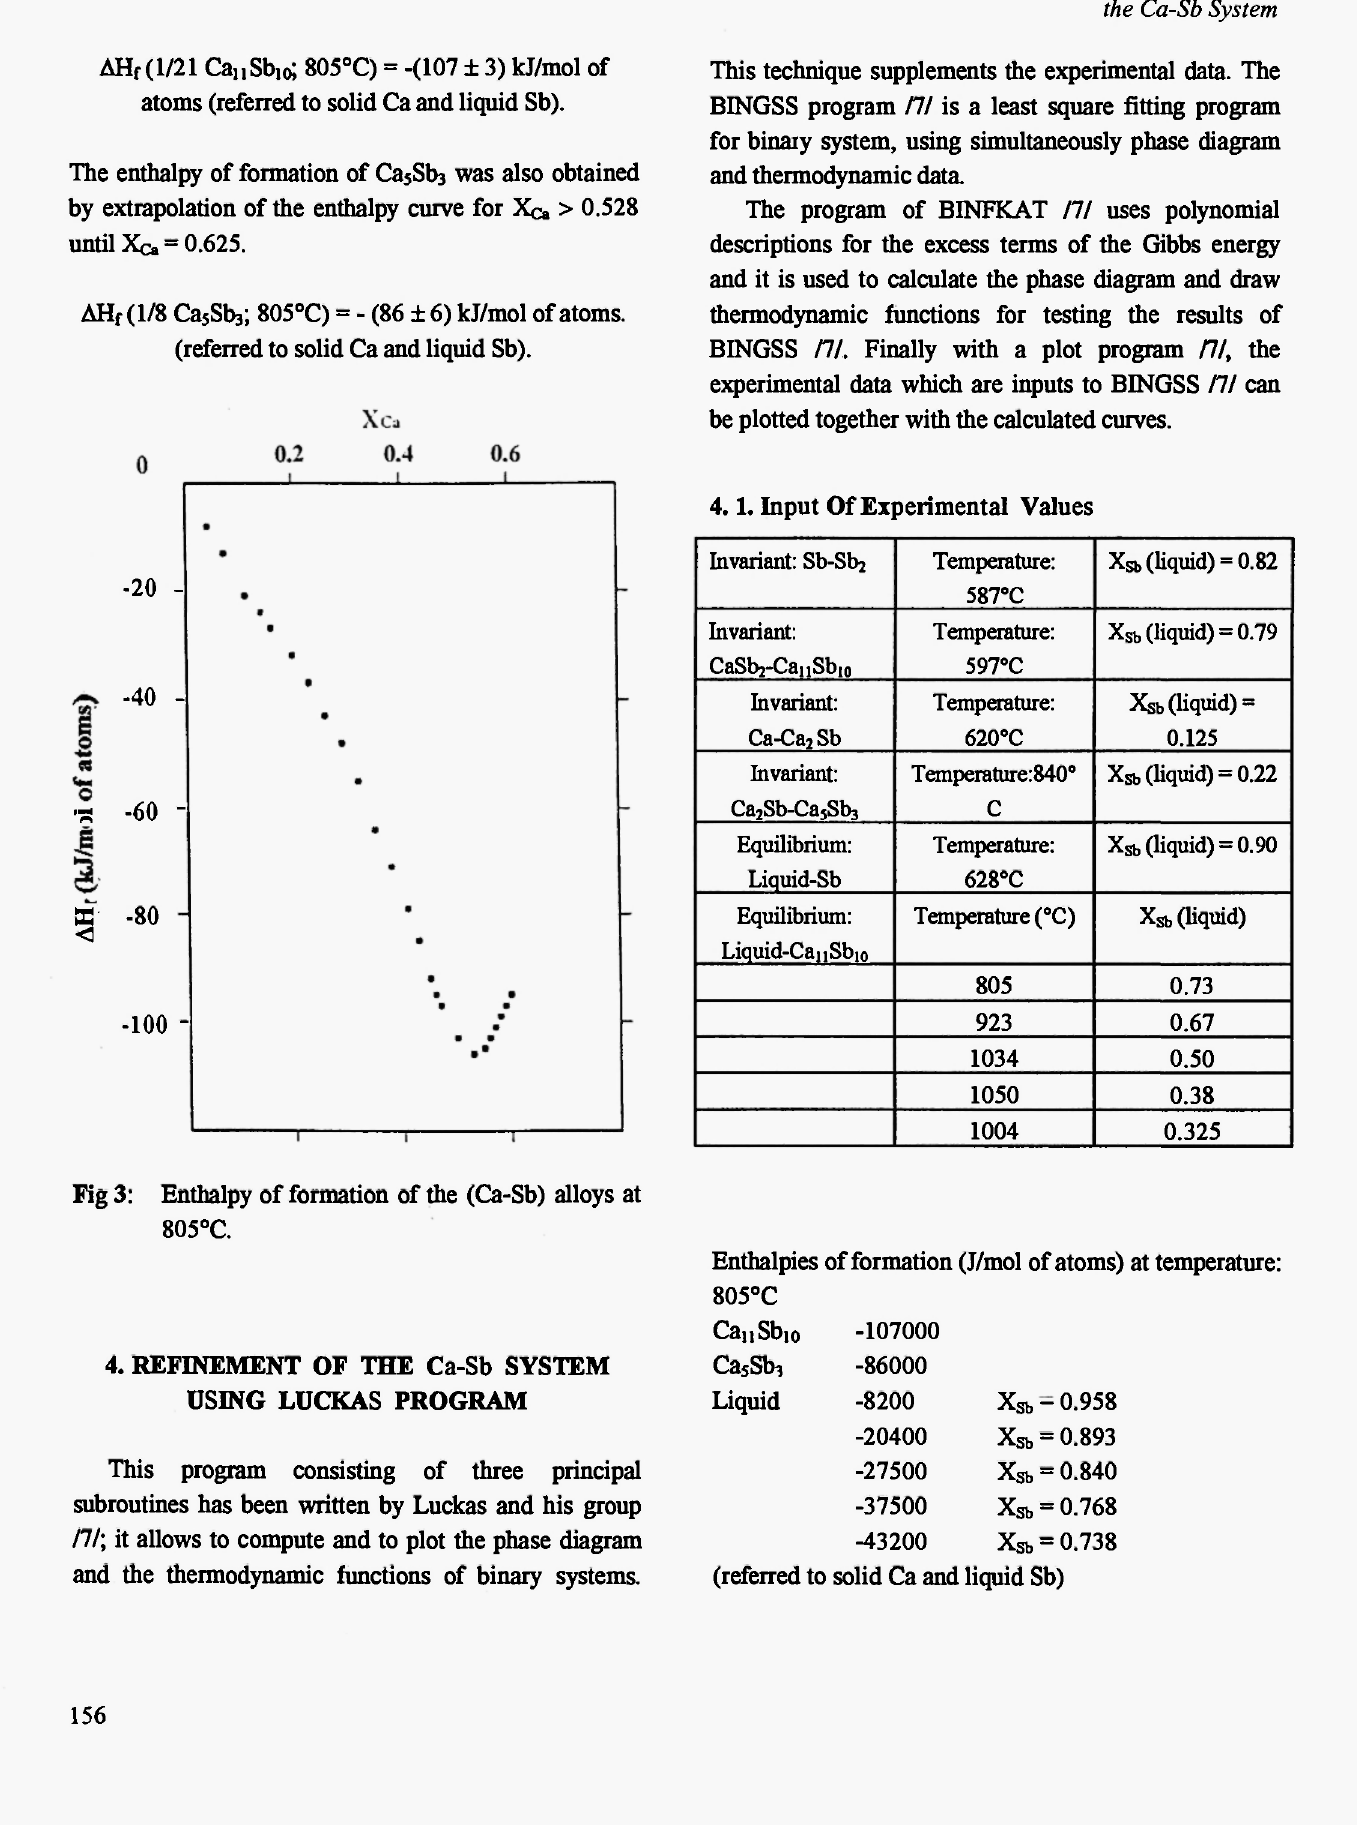
Fig 3: Enthalpy of formation of the (Ca-Sb) alloys at